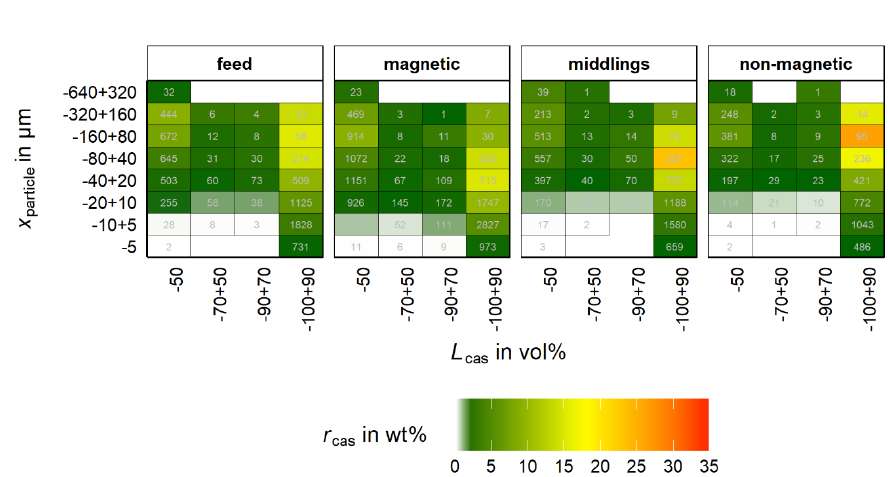
Figure 9. Distribution of cassiterite ( r cas ) as a function of x particle classes and L cas classes (recovery in each product sums up to 100%; green: 1%, yellow: 17.5%, red: 35%). The numbers in the boxes indicate the amount of particles in each